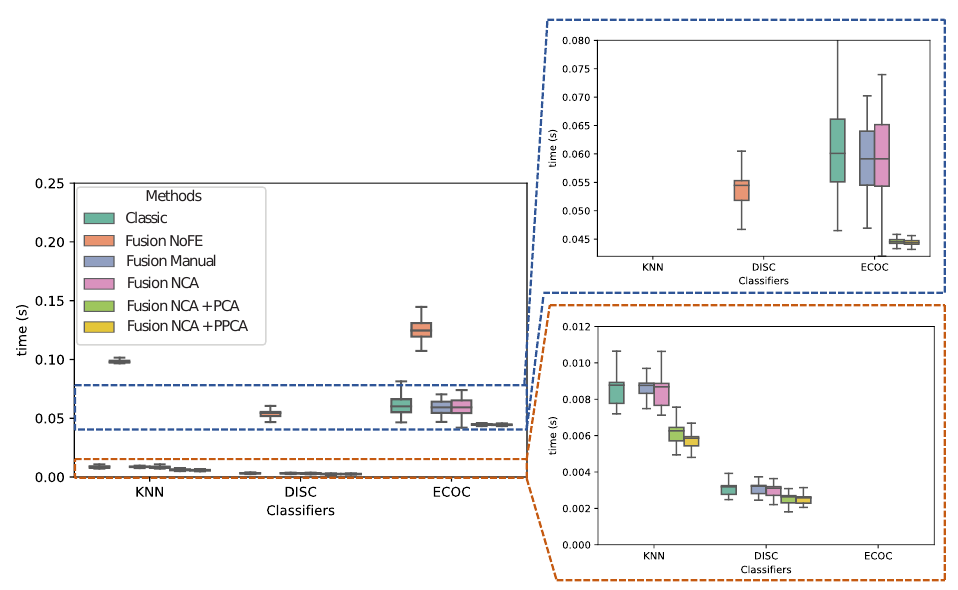
Figure 8. Execution times of the classifiers for the different combinations of classic and contextualized